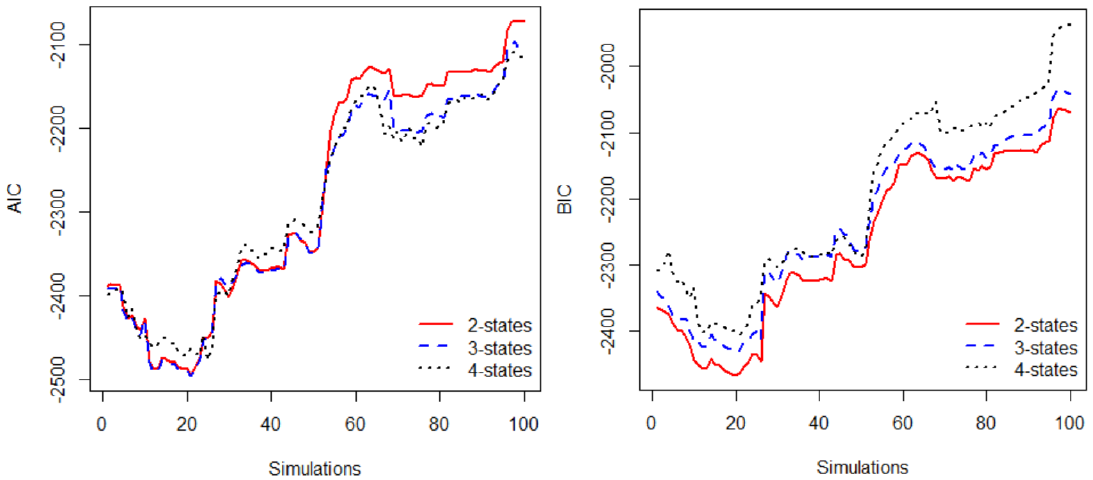
Figure 4. AIC ( left ) and BIC ( right ) for 100 parameter calibrations of HMM using Google, GOOGL, stock daily return prices.